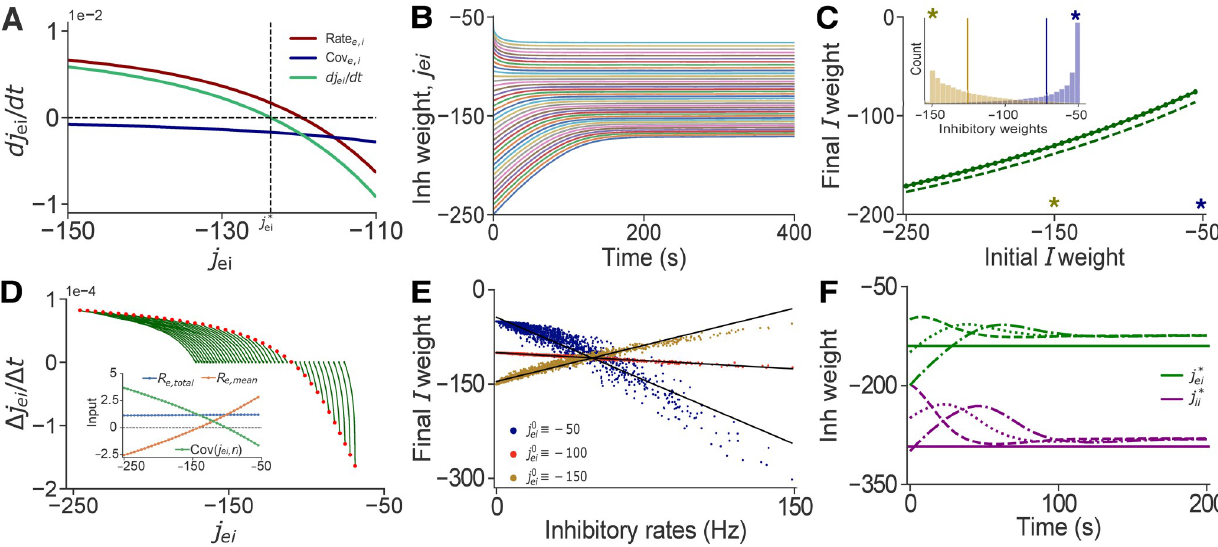
(cid:0) j 0 ei ei